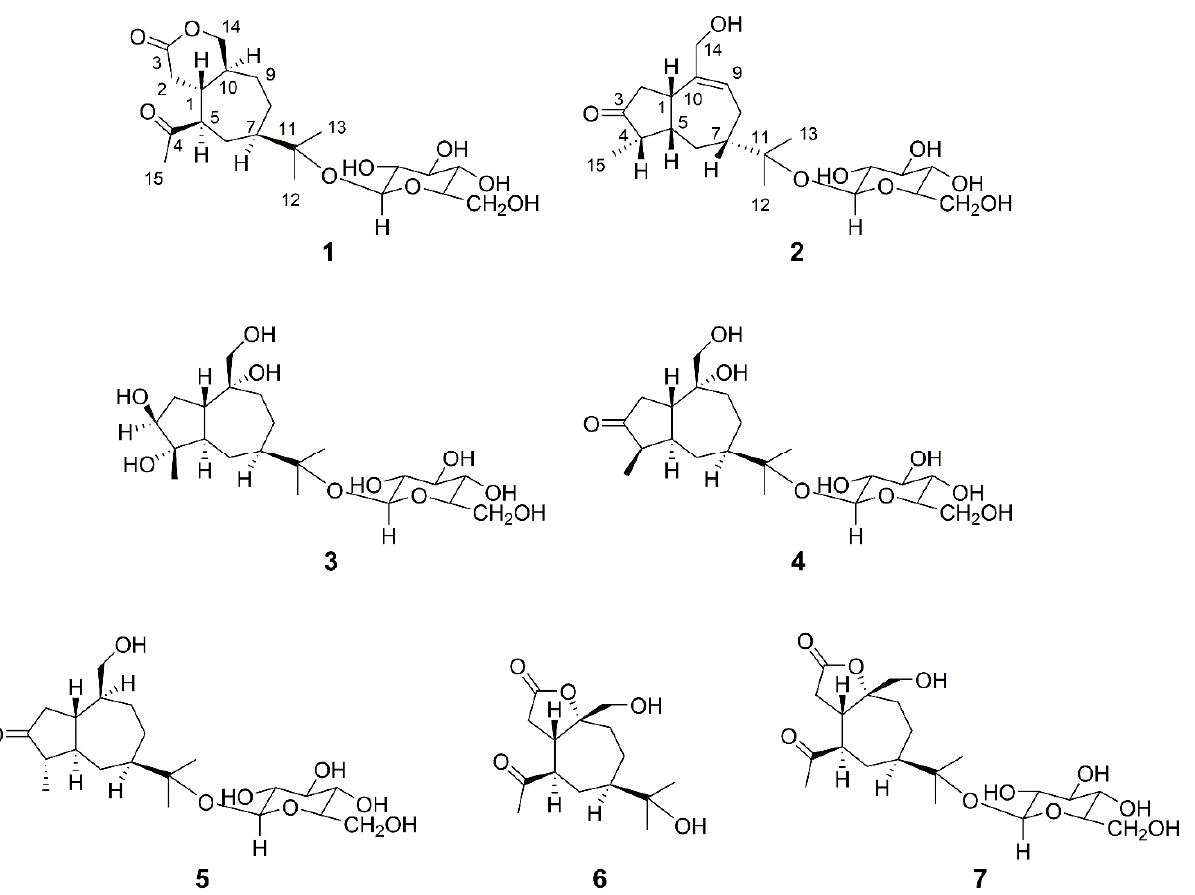
Figure 1. The chemical structures of compounds 1 – 7 . Compound 1 was isolated as a white amorphous powder with a positive optical rotation [ α ] 22 +2.1 ( c 0.28, MeOH). The positive ESI-HRMS provides [M+Na] + and [2M+Na] + D peaks at m / z 453.2067 (calcd for [M+Na] + 453.2101) and 883.4214, corresponding to a mo- lecular formula of C 21 H 34 O 9 , with five degrees of unsaturation. TLC analysis displayed a yellow spot with the spraying of 1% vanillin-H 2 SO 4 reagent, followed by heating at 105 °C after 1–2 min, and a positive reaction of the Molish reagent. The NMR and HSQC spectral data of 1 (Table 1) showed the presence of two tert- methyls, five methylenes (one of which is connected to an oxygen atom), four methines, one hydrolated quaternary carbon, one carbonyl carbon, and one acetyl group, in addition to the β -glycopyranosyl moiety. Acid hydrolysis and gas chromatographic analysis of the persilanizated derivative of the sugar indicate that the sugar was D -glucopyranose. Table 1. The 1 H-NMR (500 MHz), 13 C-NMR (125 MHz), HMBC, and ROESY spectra data for com- pound 1 ( δ , TMS, pyridine- d 5 ). No.